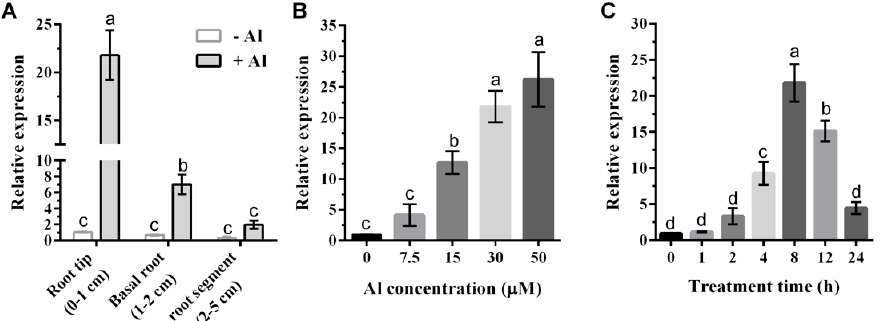
Figure 4. Soybean GmIREG3 expression analysis. ( A ) Tissue-specific expression of GmIREG3 in response to Al stress. Samples for spatial expression were taken from di ff erent root segments (0–1, 1–2 and 2–5 cm from the apex) of seedlings with or without 30 µ M Al treatment. ( B ) Dose-dependent GmIREG3 expression in soybean root tips (0–1 cm). The roots were exposed to di ff erent Al concentrations (0, 7.5, 15, 30, and 50 µ M) for 8 h. ( C ) For the time-course experiment, seedlings were exposed to 30 µ M AlCl 3 for 0, 1, 2, 4, 8, 12, or 24 h. The samples were separately harvested for qRT-PCR analysis. Values are expressed as the means ± SD ( n = 3). Di ff erent letters indicate a statistically significant di ff erence, using one-way ANOVA and Duncan’s test ( p < 0.05).